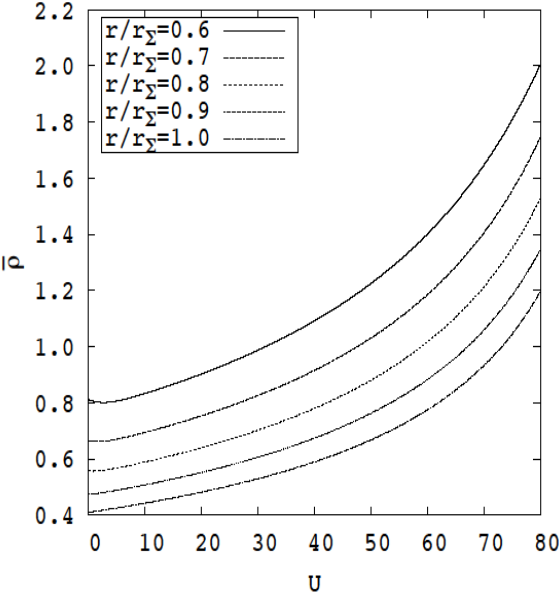
Figure 4. Changes in the matter density with time in different layers (multiplied by 10 2 ).